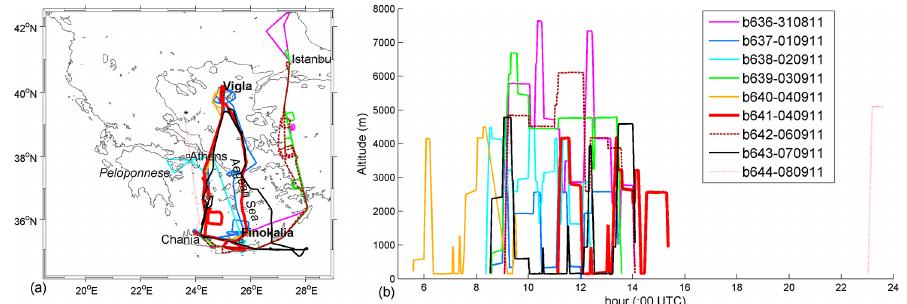
Figure 1. (a) Geographical map of the PMCAMx model domain covering the greater area of the Aegean Sea, showing also the trajectories for the nine flights during the modelling period (29 August–09 September 2011). All flights took off and landed at the airport of Chania. The aircraft over the Aegean Sea moved anti-clockwise. The ground monitoring sites are indicated by the bold fonts. The rest indicate areas discussed within the text. (b) The aircraft altitude during the time frame of each